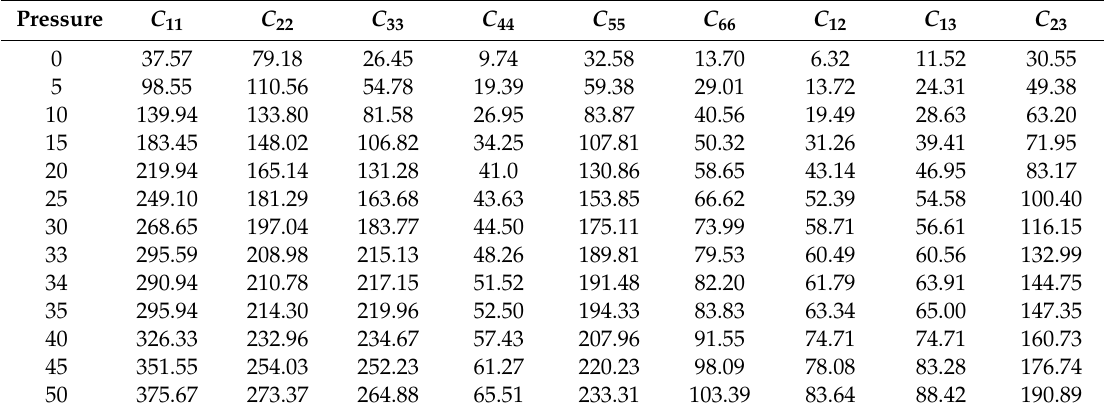
Table 3. Calculated elastic constants ( C ij in GPa) of GeSe under the applied external hydrostatic